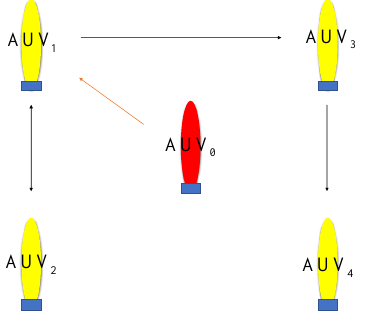
Figure 8. Alterable communication